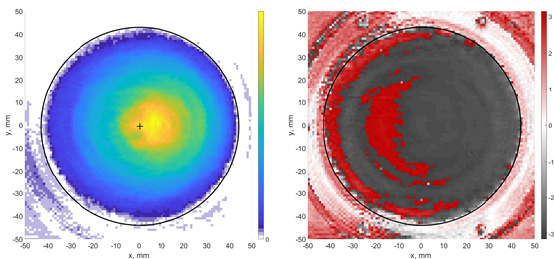
Figure 17. 2D scan with linear scaling of a field with a large LP o content corresponding to (2) of table 11